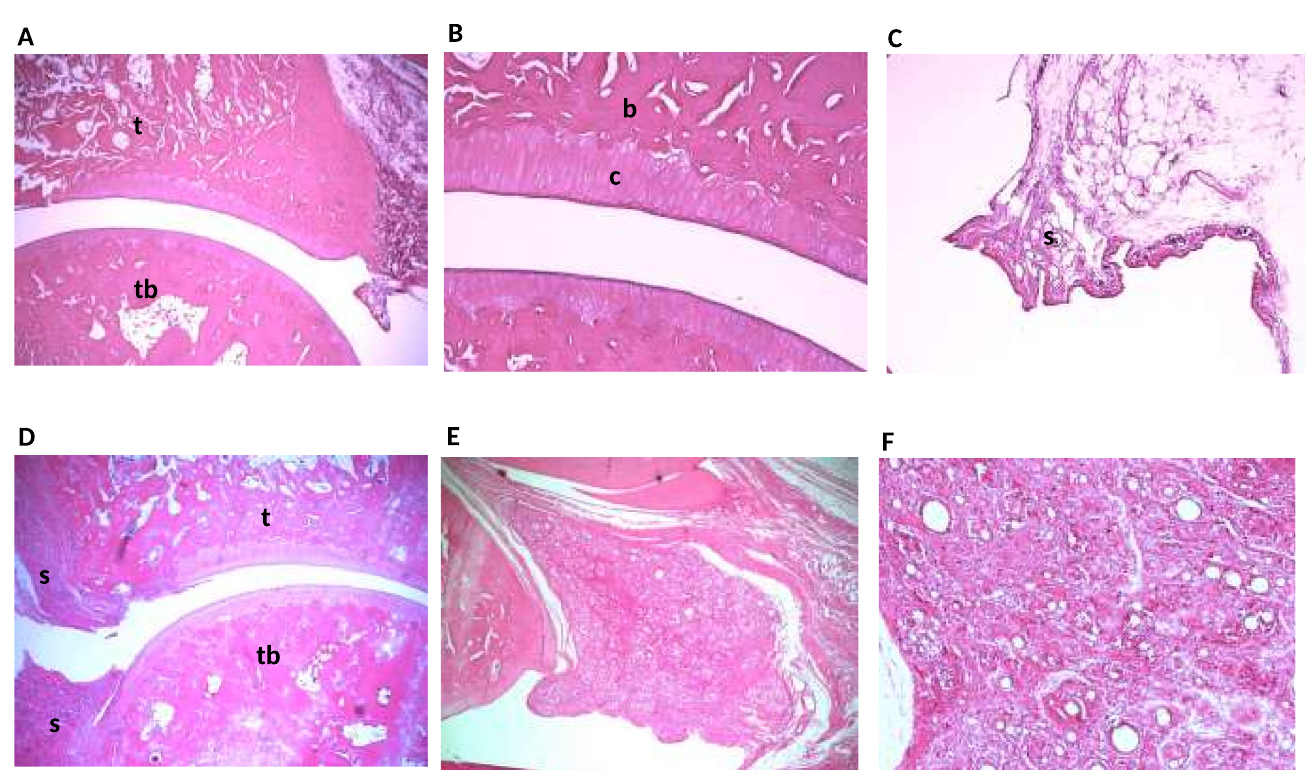
Fig 8. Hematoxylin-eosin (HE) sections. A . Normal articular spacing between tibia and the tarsal bone with smooth articular surface and a normal synovial lining (magnification 4x). B . Normal chondrocytes in columnar orientation and intact subchondral bone (magnification 4x). C . Normal synovial lining structures (Intima and subintima). Intima made up by 1–3 cells (synoviocytes) and a relatively loose connective tissue layer below with blood vessels and adipose cells (magnification 10x). D . Heavily cell-infiltrated tissue invading cranially and caudally into the tibio-tarsal joint causing local ulcerations in the articular cartilage and subchondral bone tissue (magnification 4x). E . Massive inflamed granulation tissue in the subintimal region together with synovial membrane hyperplasia (magnification 10x). F . Cells in the granulation tissue (macrophages, lymphocytes and plasma cells) surrounding lipid droplets of CFA in varying sizes (magnification 20x). In the pictures: b, bone; c, cartilage; s, synovial tissue; t, tibia; tb, tarsal bone.